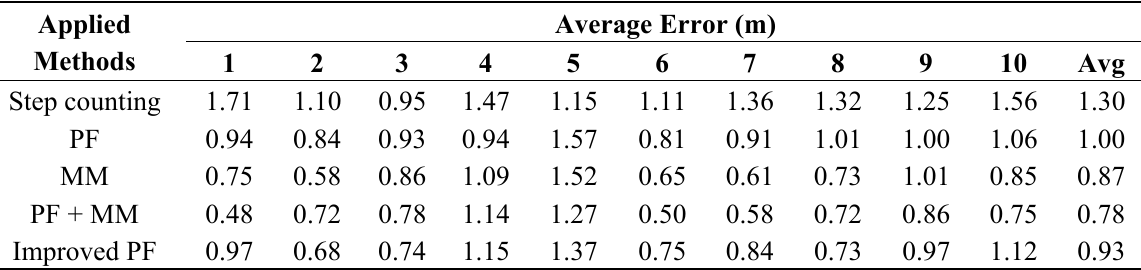
Table 2. Average error for each trial (route